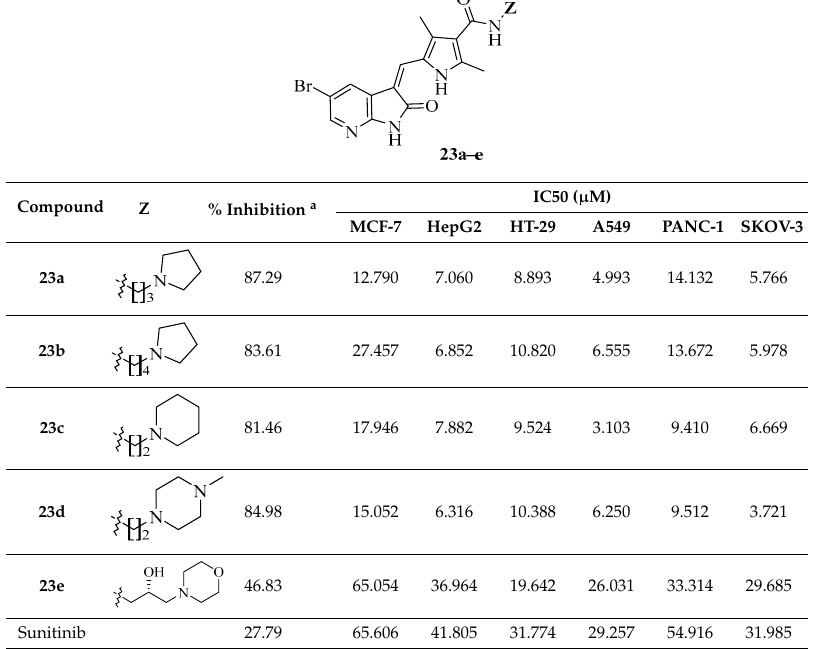
Table 1. In vitro activity of target compounds 23a – e against six cell lines.